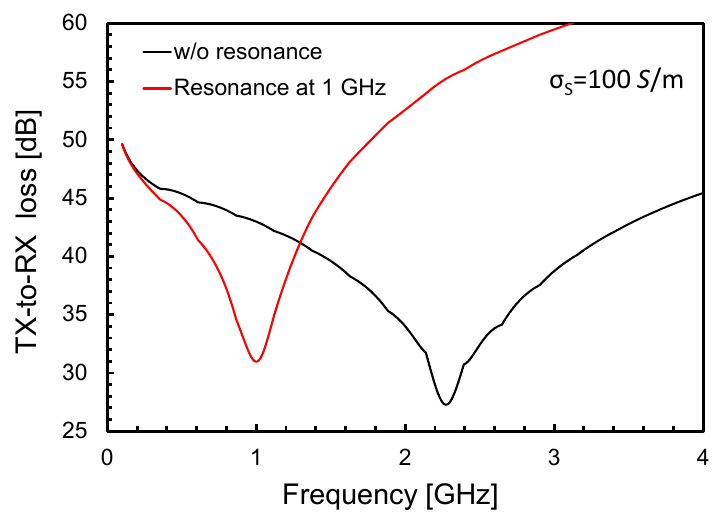
Figure 7. TRX performance in open-circuit conditions for σ S = 100 S /m.